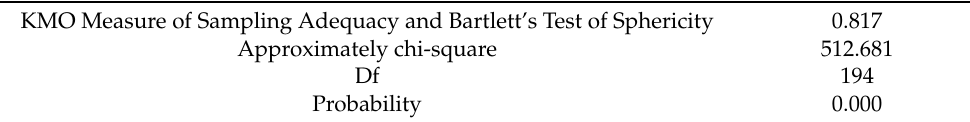
Table 4. Kaiser–Meyer–Olkin (KMO) and Bartlett’s test results.